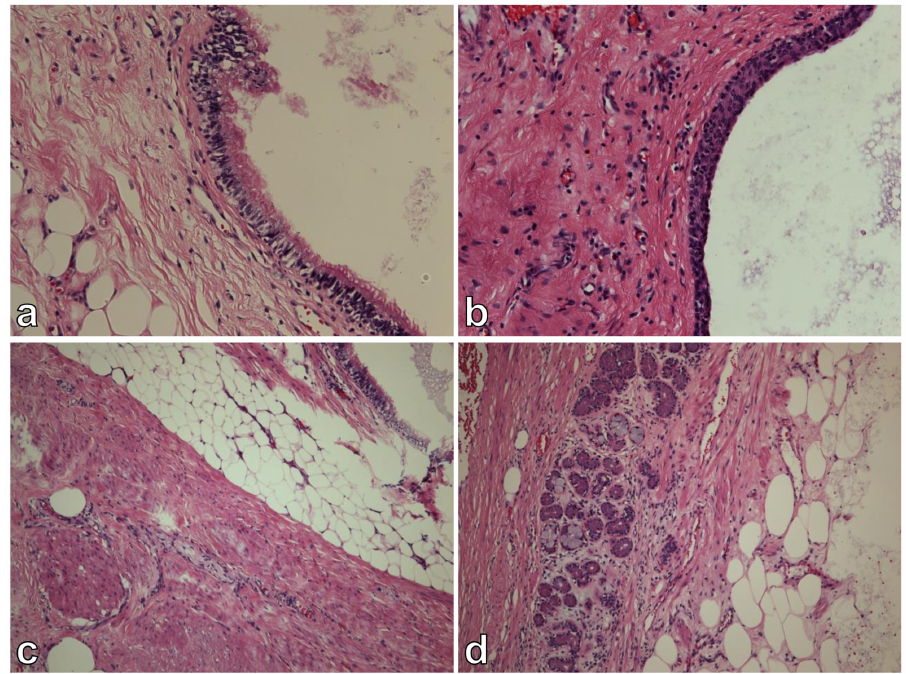
Figure 4. Histologic analysis. Cystic tumor with respiratory ( a ) and squamous cell ( b ) epithelium lining. Fibro adipose tissue, muscle cells, and salivary glands were also observed ( c , d ).